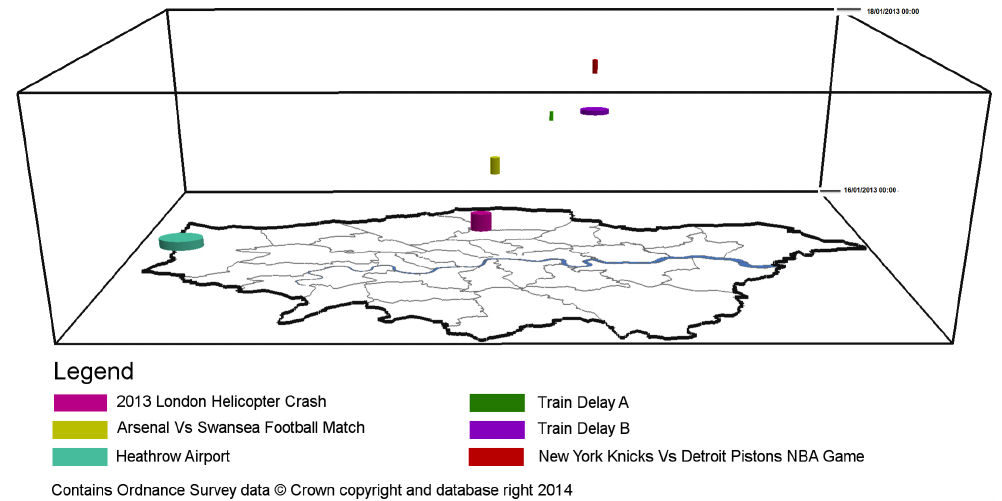
Figure 7. Hourly cluster events identified within London between 16th January and 17th January 2013. doi:10.1371/journal.pone.0097807.g007 PLOS ONE |